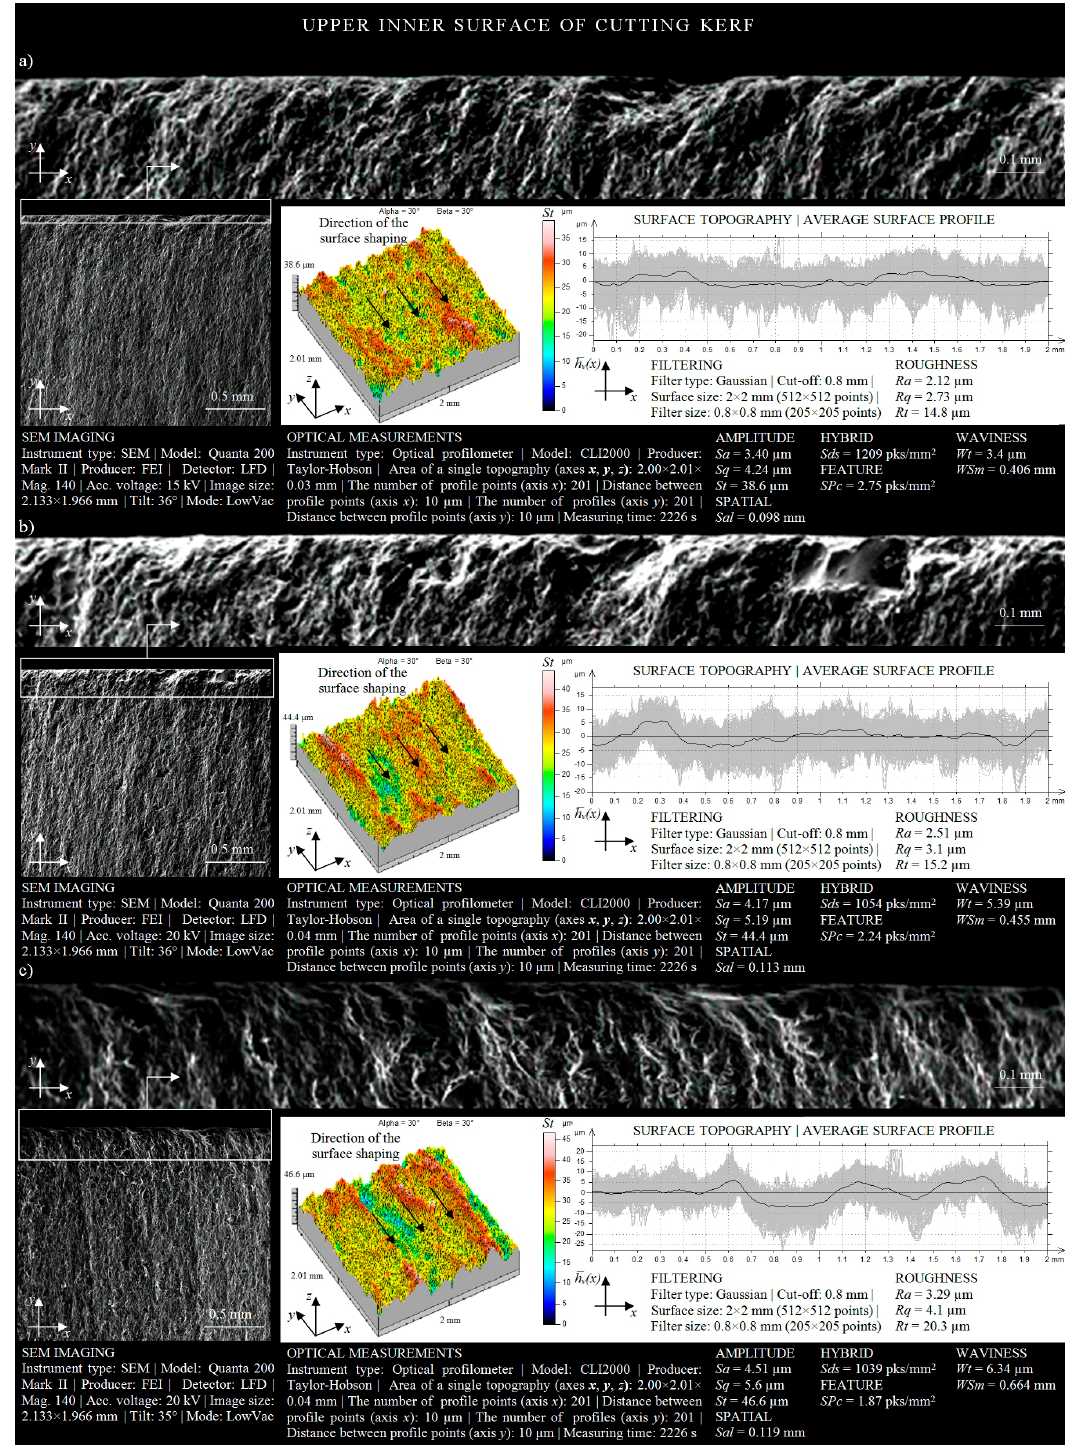
Figure 6. Collection of selected results of experimental studies obtained for the upper IS in a situation when the AWJ entered the sample surface ( l = 1.5 mm, d o = 0.38 mm, d f = 0.76 mm, m a = 0.336 kg / min, v = 427 mm / min, p = 360 MPa, g = 8 mm): ( a ) r = 50 mm; ( b ) r = 35 mm; ( c ) r = 15 mm.